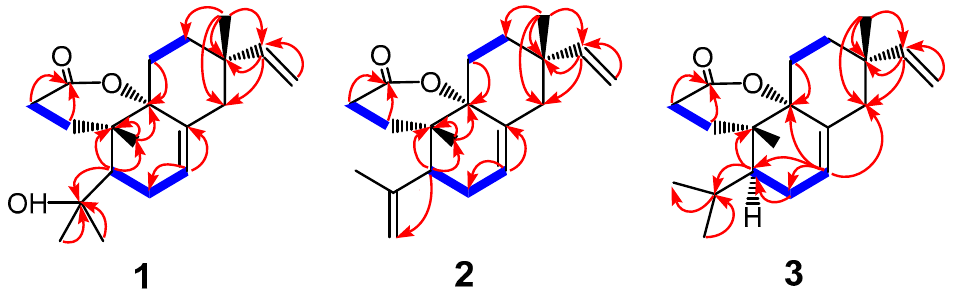
Figure 2. Key HMBC (in red) and COSY (in blue) correlations for compounds 1 – 3 .